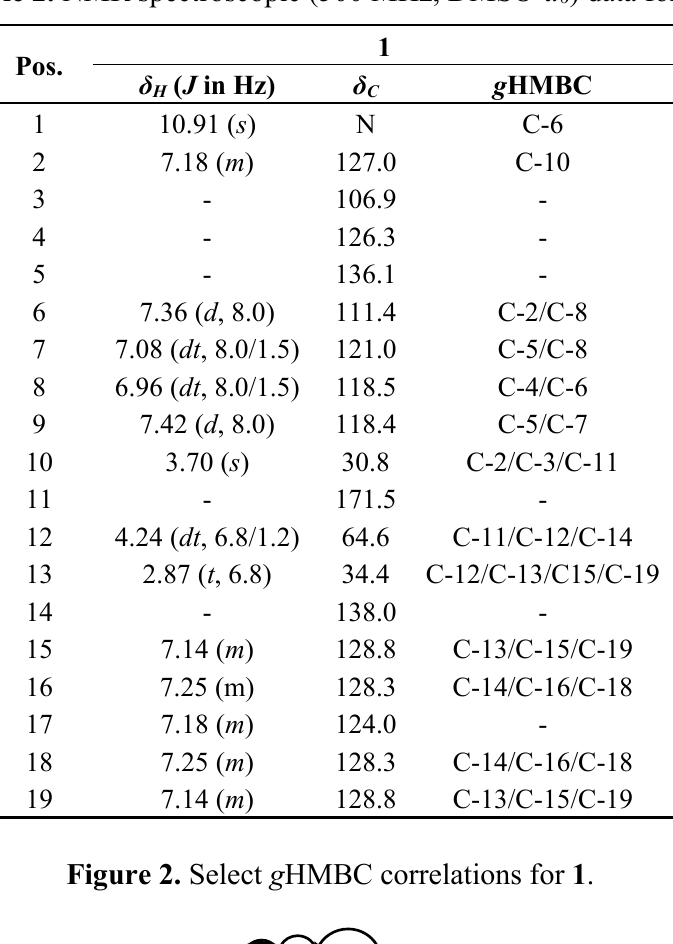
Table 2. NMR spectroscopic (500 MHz, DMSO -d 6 ) data for 1 .